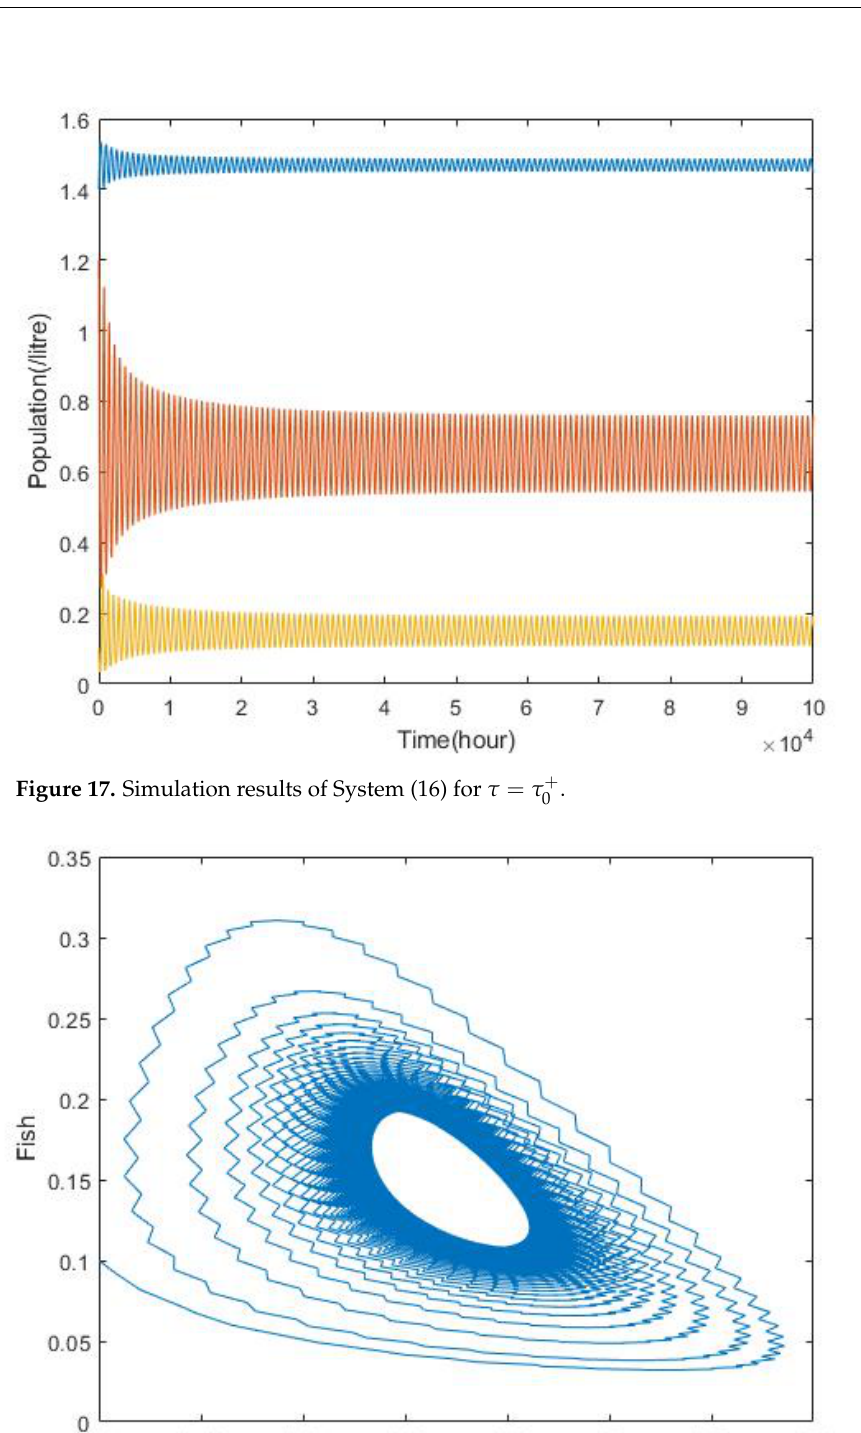
Figure 18. Equilibrium between the TPP and fish populations loses its stability for τ = τ +